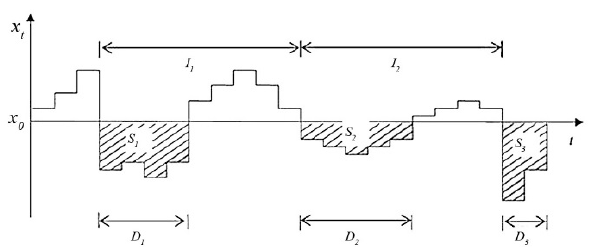
Figure 2. Drought characteristics using the run theory: D 1 , D 2 , … denote drought duration; S 1 , S 2 , … denote drought severity; I 1 , I 2 , … denote drought arrival time.